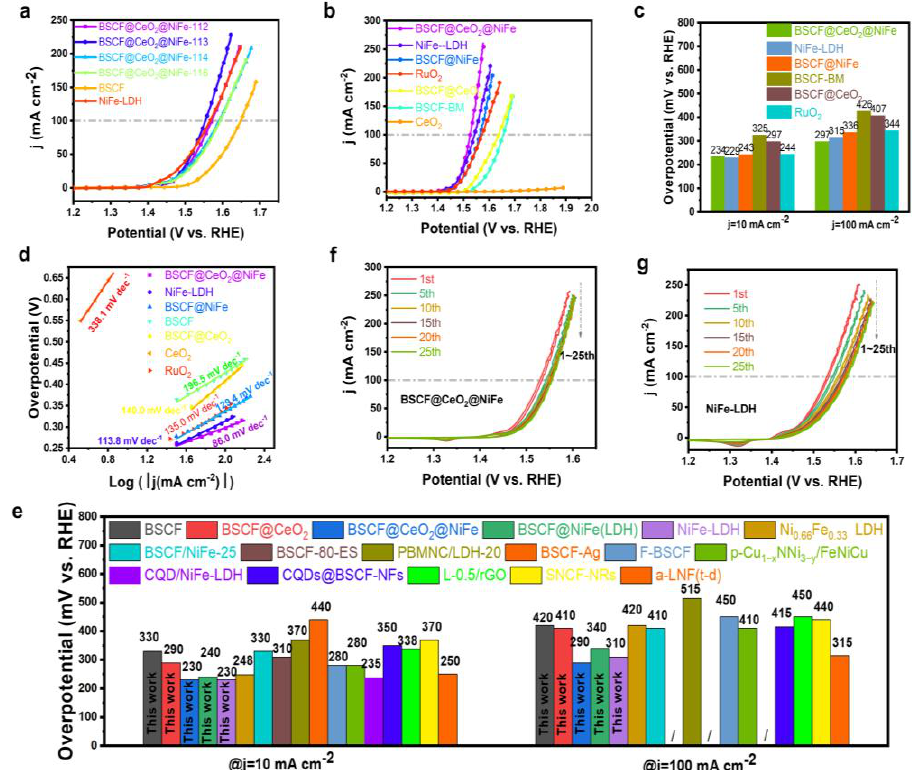
Figure 2. OER LSV curves of ( a ) the BSCF@CeO 2 @NiFe-LDH with the different compositions and ( b ) BSCF@CeO 2 @NiFe, BSCF@NiFe, NiFe-LDH, BSCF@CeO 2 , BSCF, CeO 2 , and RuO 2 in 1 M KOH solution. ( c ) Corresponding overpotentials at 10 and 100 mA cm −2 , ( d ) Tafel plots. CV curves of BSCF@CeO 2 @NiFe . ( e ) Comparison of the OER activities of the different type of composite perovskites in this work and the other reports, and ( f ) NiFe-LDH ( g ) at the different scanning circles in 1 M KOH solution.